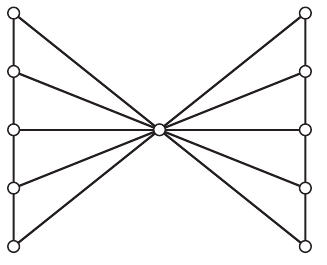
Figure 4. The bowknot graph B 5,5